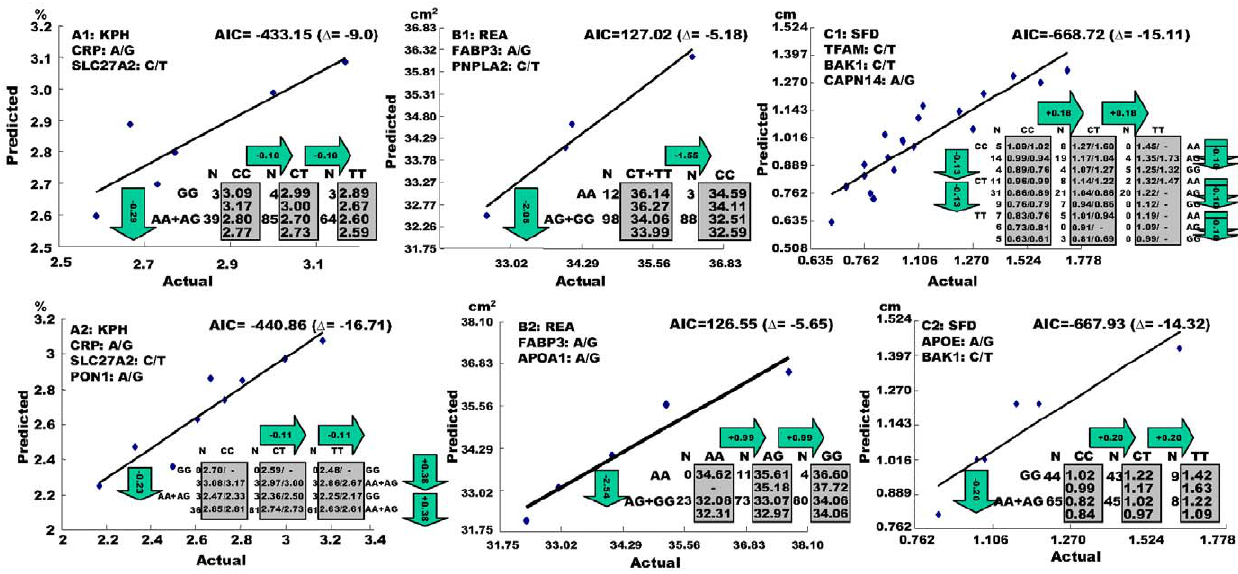
Figure 3. Identification of genetic networks related to RCT pathway via Akaiki Information Criterion based model comparison. A1, B1 and C1 are genetic networks previously reported by Jiang et al. (2009 with permission), while A2, B2 and C2 are newly identified networks in the present study for KPH, REA and SFD, respectively. The x-axis and y-axis represent actual and predicted trait (genotypic) values. The numbers in arrows represent substitution effects of one type of genotypes or allele for another one. In the graph, AIC = computed AIC value for a specific model, say A1, and D = the difference of AIC values, say, between model A1 and the base model A0. The AIC values for the three base models, A0, B0 and C0, were 2 424.15, 132.2, and 2 653.61, respectively.